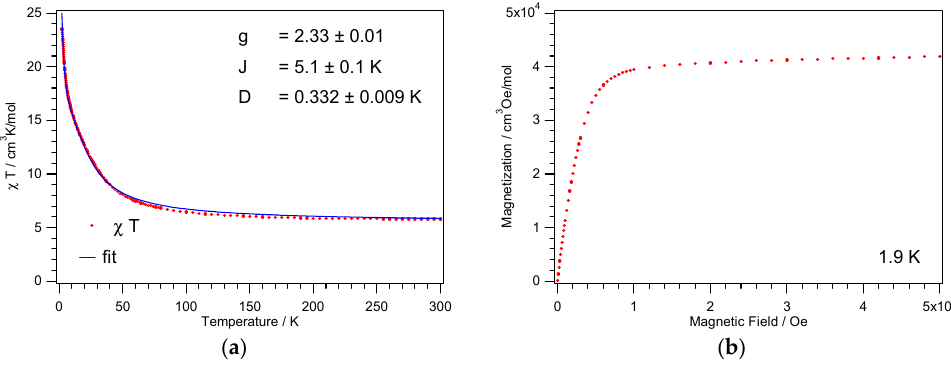
Figure 6. Temperature dependence of the χ M T product ( a ) and magnetization vs field ( b ) for 2 . The field dependence of the magnetization at 1.9 K for 1 and 2 is shown in Figures 5b and 6b. The magnetization shows a rapid increase up to a field of 10 kOe, after which it increases only gradually reaching at 50 kOe values of 8.8 and 7.7 μ B , respectively. The initial steep increase of the magnetization points as well to intramolecular ferromagnetic interactions. Given that out of the twelve Ni–O–Ni angles per cluster, eight lie in the ferromagnetic and only four in the antiferromagnetic regime, it seems useful to apply a Heisenberg Hamiltonian containing two coupling parameters, J 1 and J 2 ,